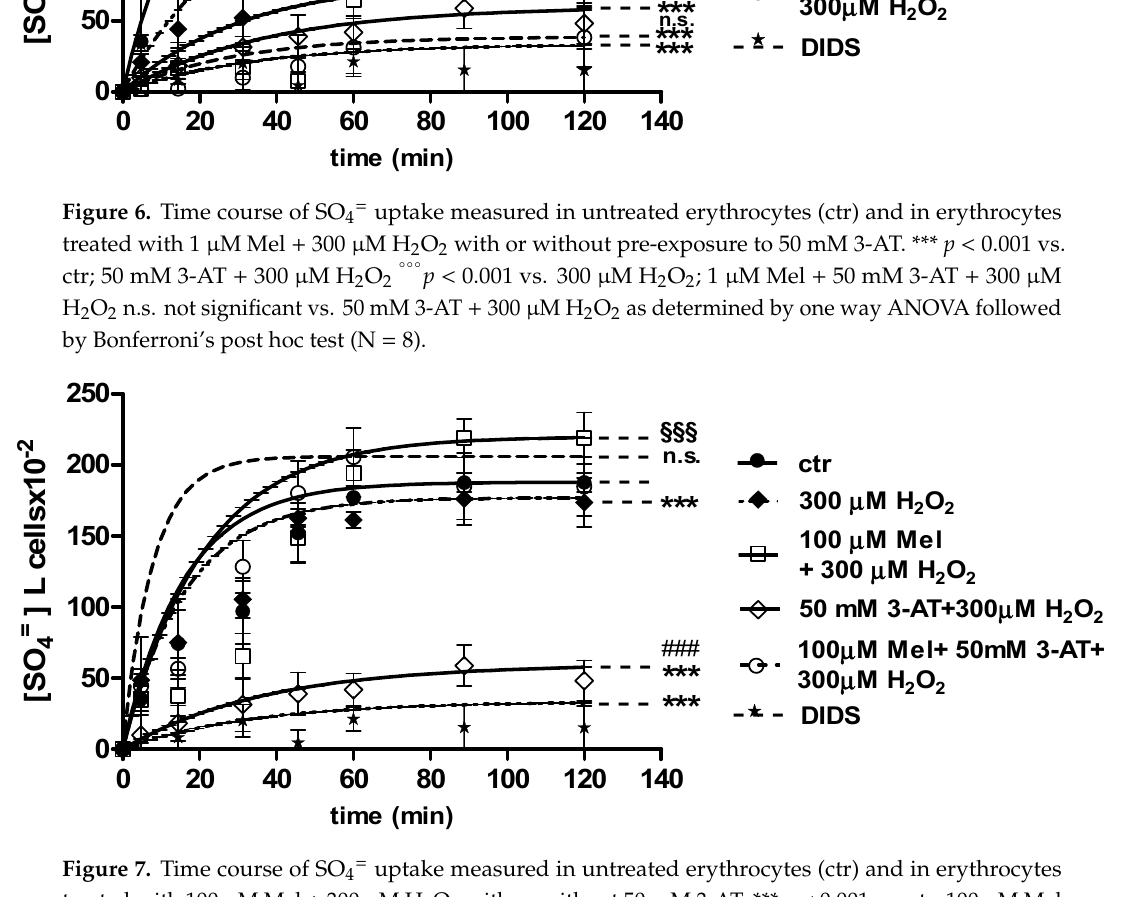
Figure 6. Time course of SO 4= uptake measured in untreated erythrocytes (ctr) and in erythrocytes treated with 1 μ M Mel + 300 μ M H 2 O 2 with or without pre-exposure to 50 mM 3-AT. *** p < 0.001 vs. ctr; 50 mM 3-AT + 300 μ M H 2 O 2 °°° p < 0.001 vs. 300 μ M H 2 O 2 ; 1 μ M Mel + 50 mM 3-AT + 300 μ M H 2 O 2 n.s. not significant vs. 50 mM 3-AT + 300 μ M H 2 O 2 as determined by one way ANOVA followed by Bonferroni’s post hoc test (N = 8).